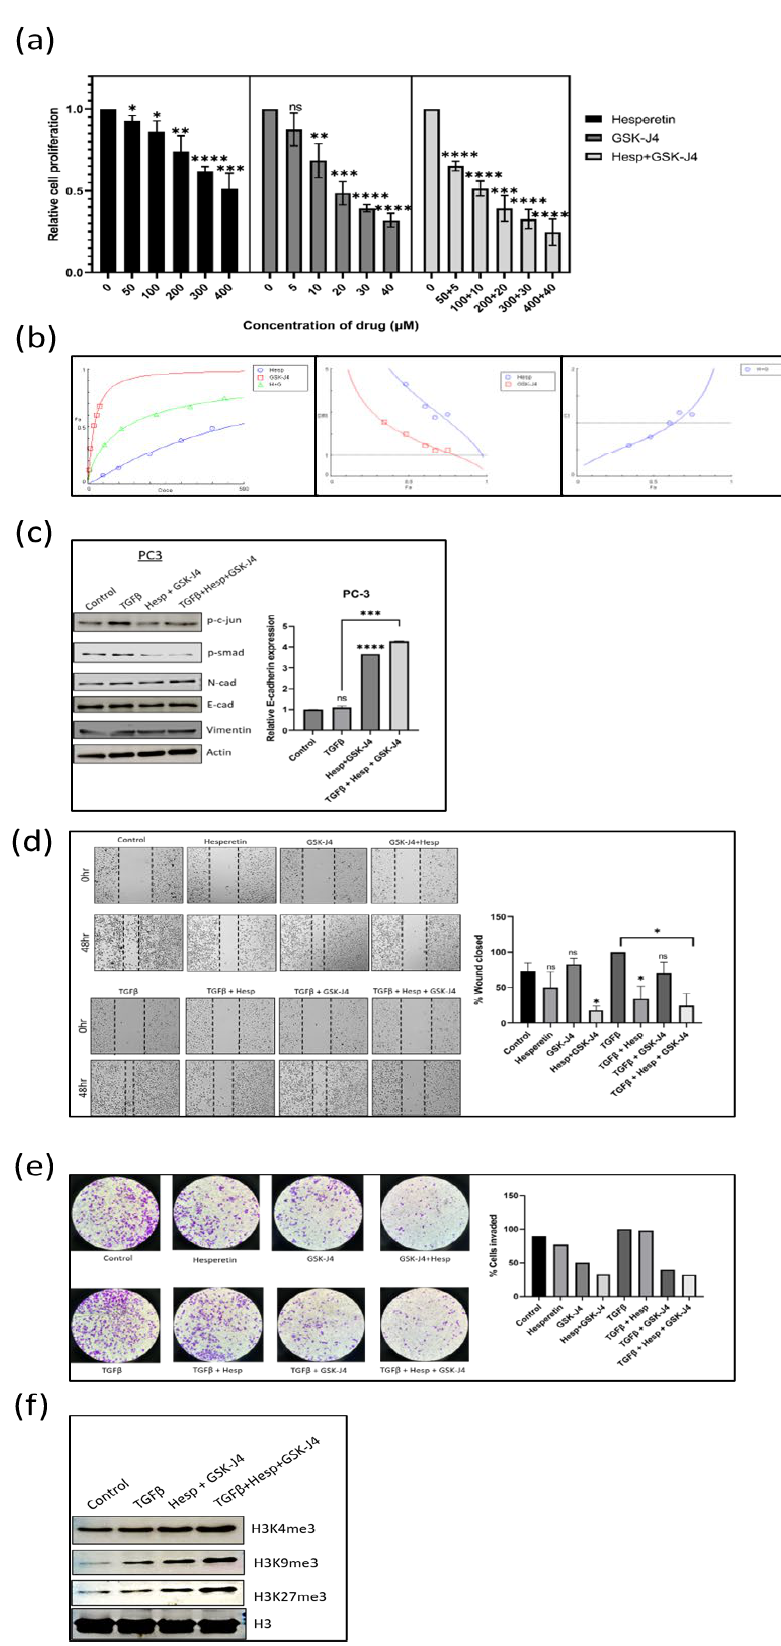
Figure 3. ( a ) MTT assay in the PC3 cell line to determine the effect of GSK-J4 and hesperetin alone and, in combination, on cell proliferation. DMSO was taken as the vehicle control. ( b )